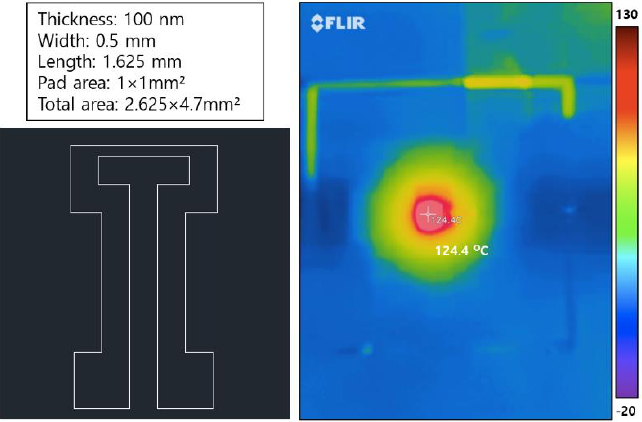
Figure A2. Scheme of a micro-heater. The IR image shows the heating temperature up to 124.4 degrees Celsius.